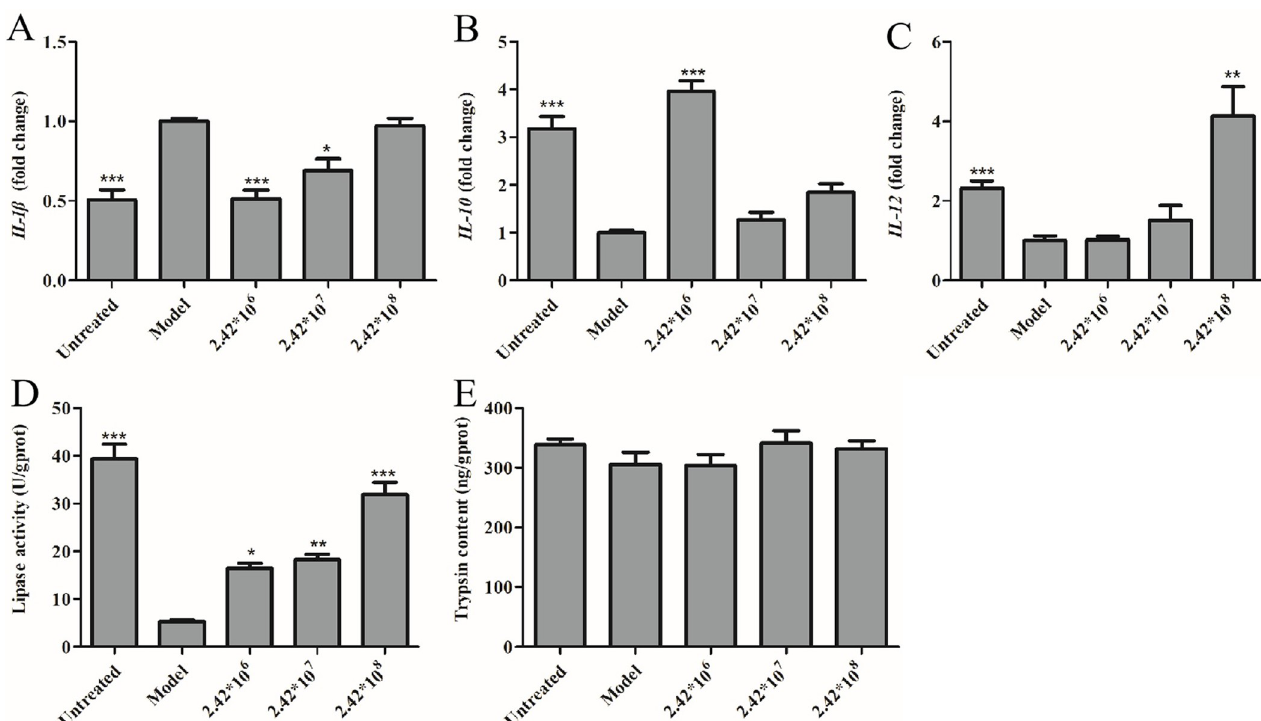
Fig 3. The inflammatory and immunity gene expression and the digestive enzyme quantifications in the intestinal tract tissues of the irregularly high- glucose diet-induced intestinal functional disorders of adult zebrafish. IL -1 β gene levels (A), IL-10 gene levels (B) and IL-12 gene levels (C) in the adult zebrafish intestines. Lipase activity (D) and trypsin content (E) in the adult zebrafish intestines. Data were expressed as means ± S.E.M. Compared with the model group, � p < 0.05, �� p < 0.01, ��� p < 0.001.